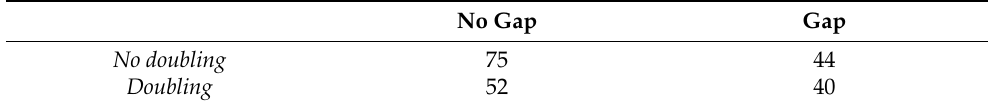
Table 5. The number of dialects exhibiting gaps (in the first person singular) and doubling of the wh element who . Dataset: Manzini and Savoia (2005) and selected data points from the ASIt database. No Gap Gap No doubling 75 44 Doubling 52